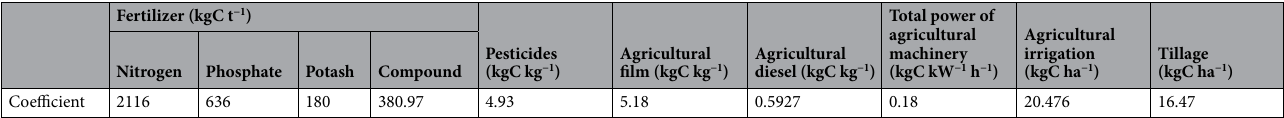
Table 1. Carbon emission factors for farmland